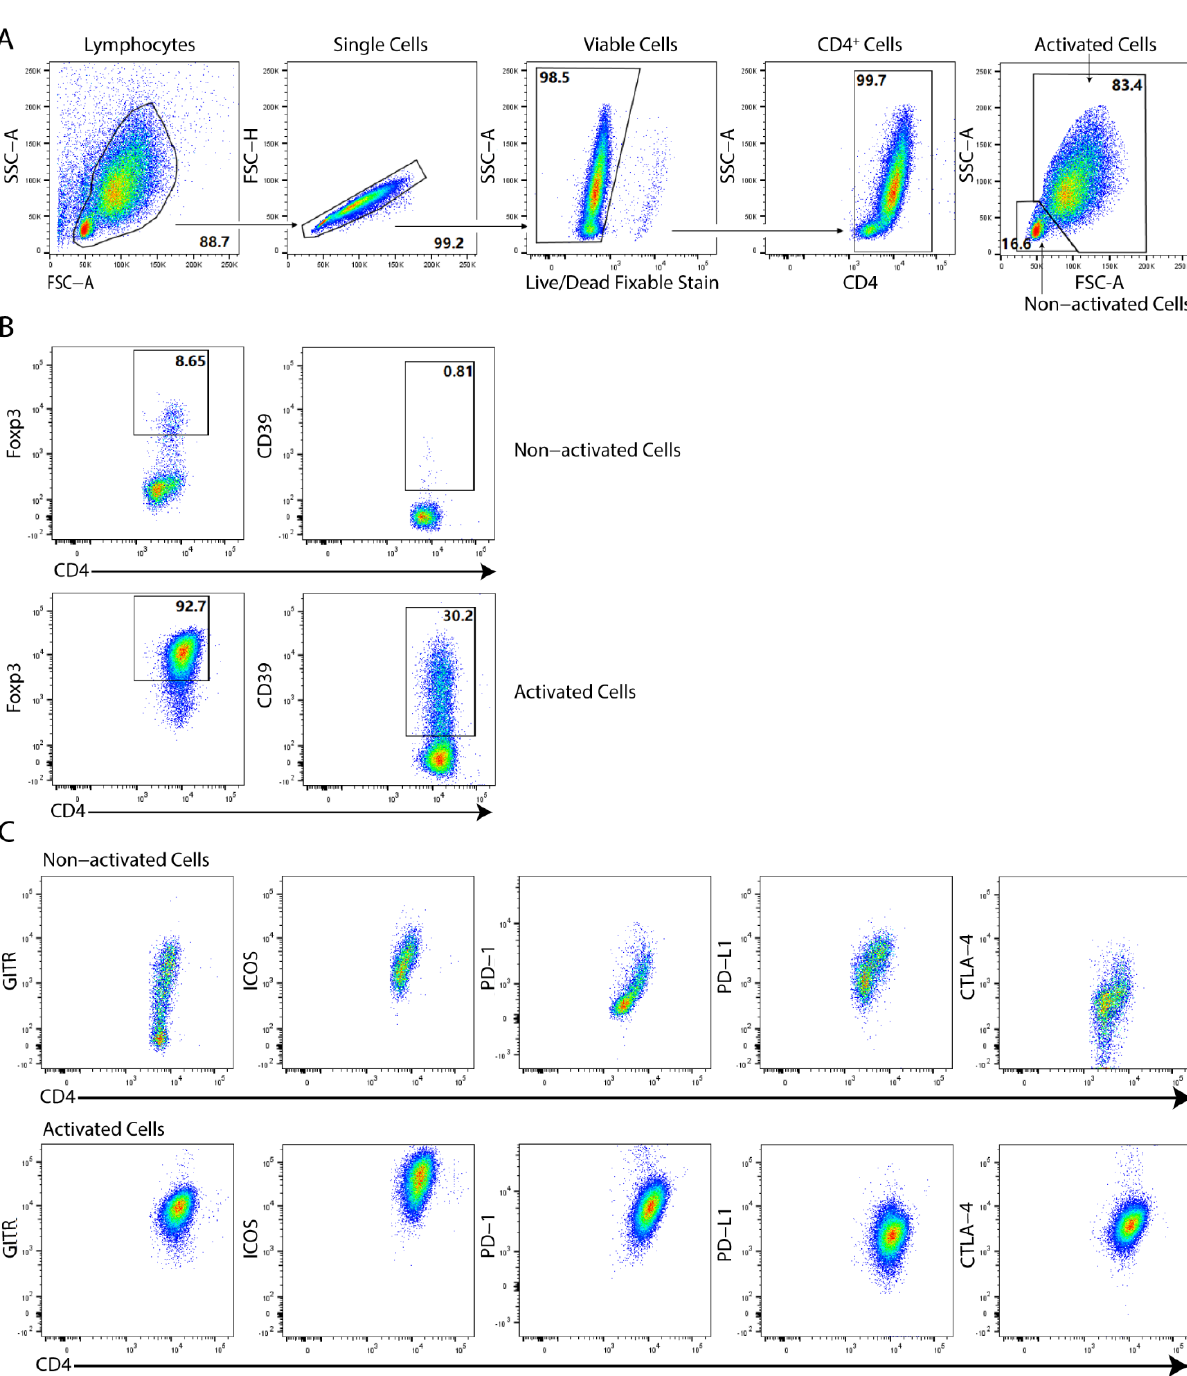
Figure 2. Flow cytometric gating strategy for the phenotypic markers of human in vitro induced regulatory T cells (iTregs) generated from adult naïve CD4 + cells. ( A ) Flow cytometric gating strategy for lymphocytes, single cells, viable cells, CD4 + cells, and non-activated and activated iTregs generated from adult naïve CD4 + cells. ( B ) Representative dot plots showing the percentages of Foxp3 and CD39 gated on either non-activated (left panels) or activated (right panels) iTreg cells. ( C ) Representative dot plots showing the GITR, ICOS, PD-1, PD-L1, and CTLA-4 expression patterns on either non-activated or activated iTreg cells generated from adult naïve CD4 + cells with propionate. Data summarize thirteen independent experiments.